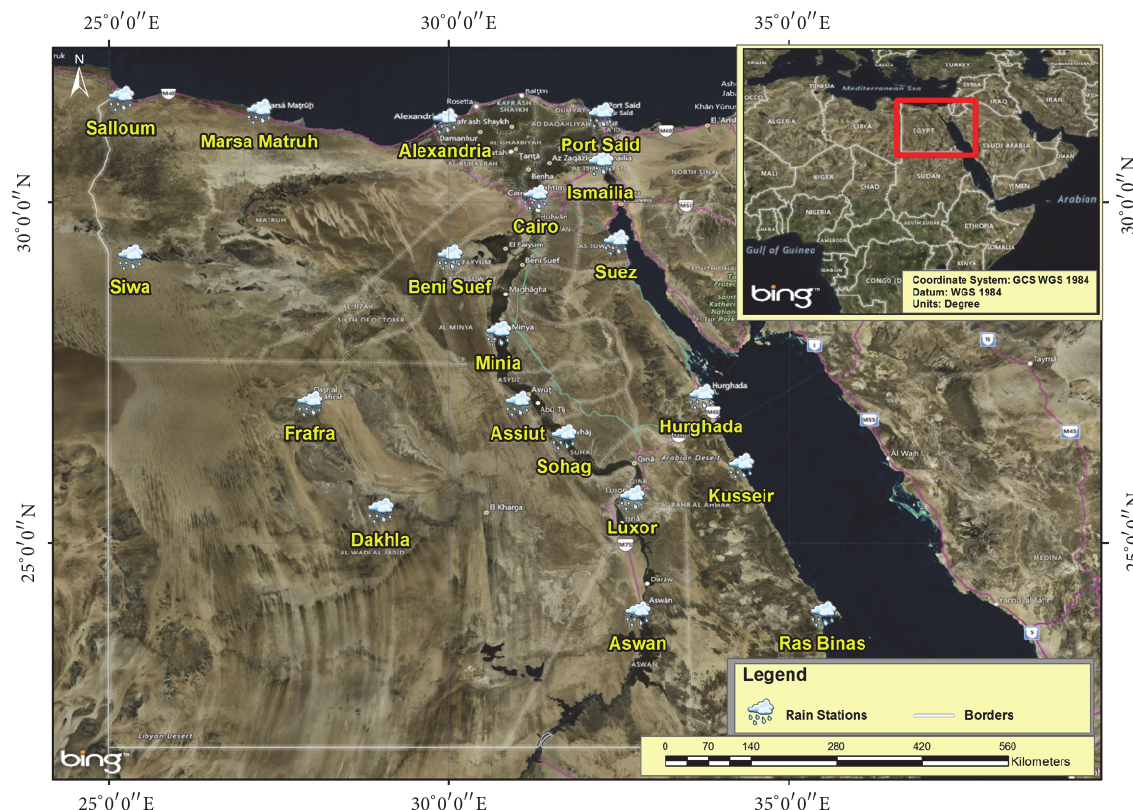
Figure 2: Location of the available rainfall